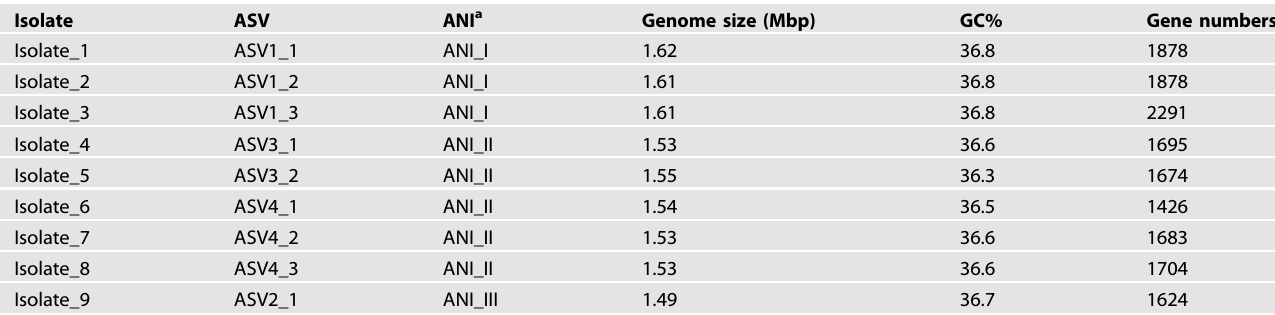
a ANI group was classi fi ed by 99.5% average nucleotide identity based on whole – genome sequences.